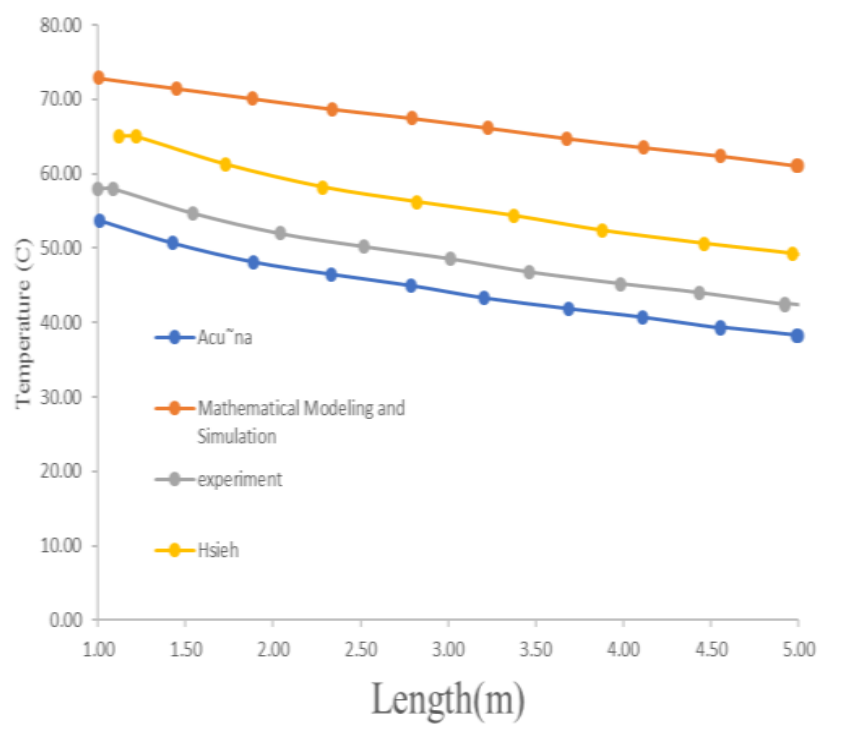
Figure 13. Outlet temperature from the collector in similar research in different lengths of absorber tube.